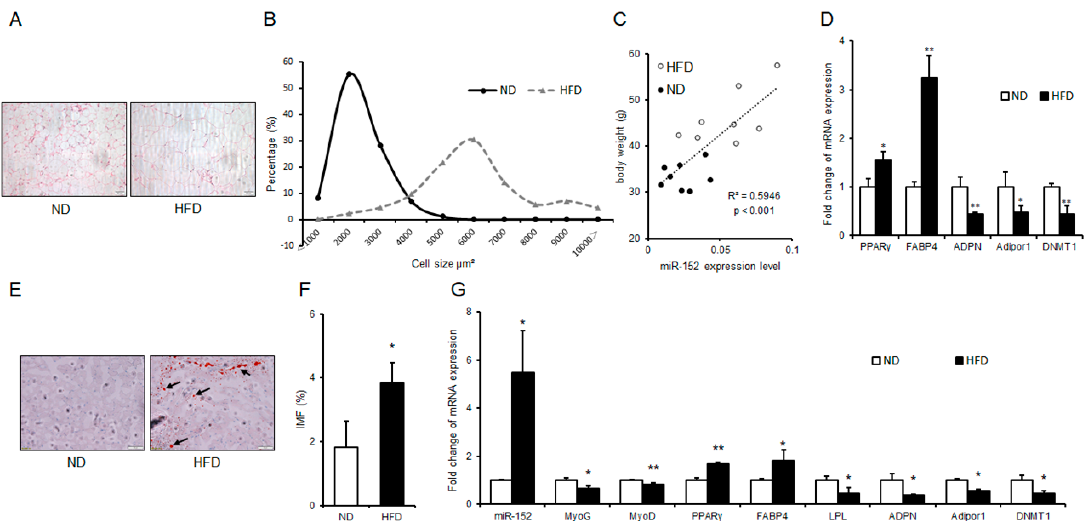
Figure 5. miR-152 is correlated with adipogenesis and intramuscular fat formation in vivo. ( A ) H and E staining for the gonadal fat and sizes of adipose cells were analyzed by using ImageJ. ( B ) The cell size profiling of gonadal fat mass. ( C ) Correlation analysis between miR-152 expression levels in gonadal fat mass and bodyweight of mice, n = 16; ( D ) The mRNA expression levels of PPAR γ , FABP4, ADPN, Adipor1 and DNMT1 were detected in the gonadal fat mass of normal diet (ND) mice and high fat diet (HFD) mice; ( E ) Oil Red O staining for intramuscular fat in gastrocnemius muscle of ND mice and HFD mice (arrowheads point to lipid droplets) and ( F ) Intramuscular fat (IMF) levels was detected, n = 3; ( G ) The miRNA expression level of miR-152 and the mRNA expression levels of MyOG, MyOD, PPAR γ , FABP4, LPL, ADPN, Adipor1 and DNMT1 were detected in the gastrocnemius muscle of ND mice and HFD mice, n = 3. Results are presented as means ± SD. * p < 0.05; ** p < 0.01. Scale = 50 μ m.